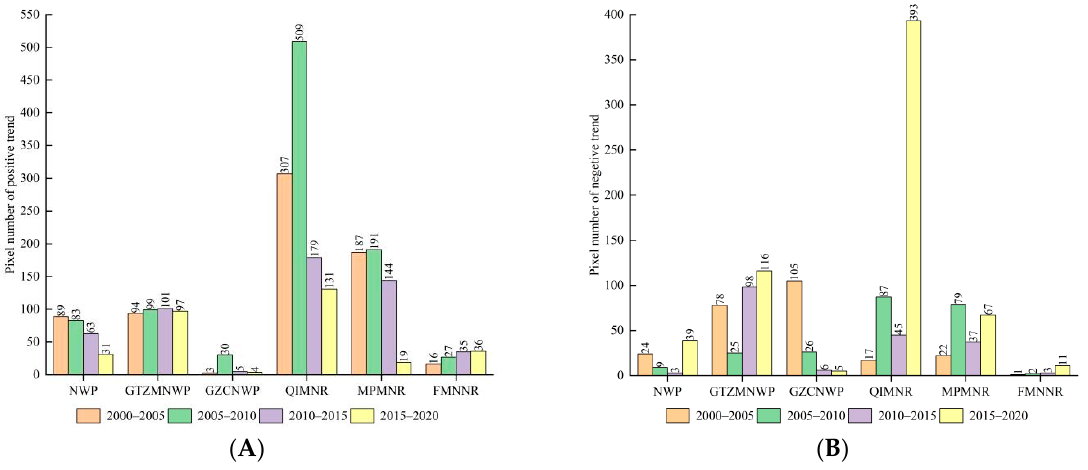
Figure 9. The pixel number of growth trends of stable mangroves in six nature reserves from 2000 to 2020; ( A ) the pixel number of positive growth trends, ( B ) the pixel number of negative growth trends.